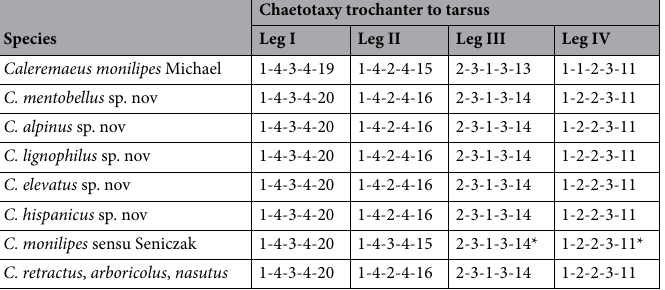
Table 2. Comparison of leg setation of all recent Caleremaeus species. *Corrected in Norton & Behan- Pelletier 24